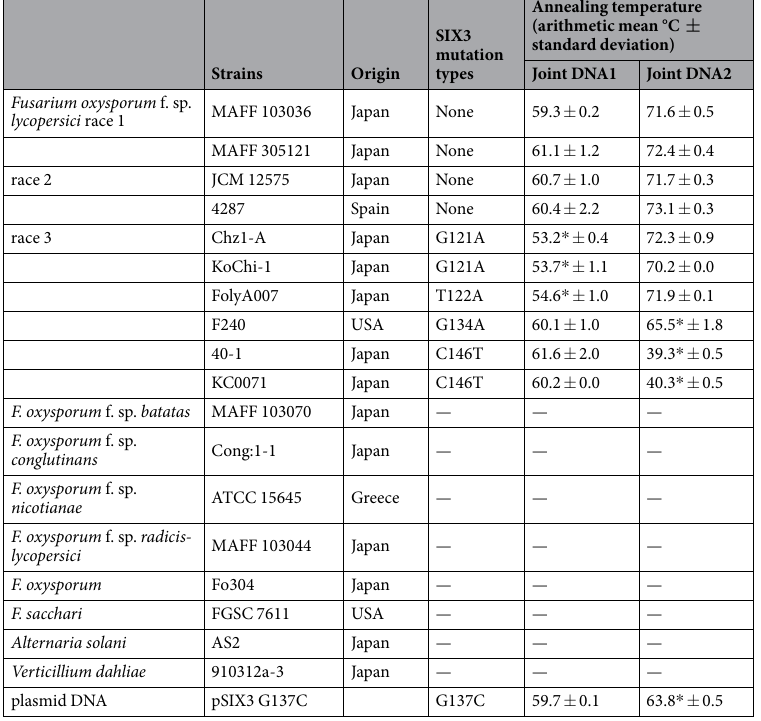
Table 1. Melting temperatures of Joint DNAs. + , Detection − , no detection * , relatively low melting temperature of each joint DNA.